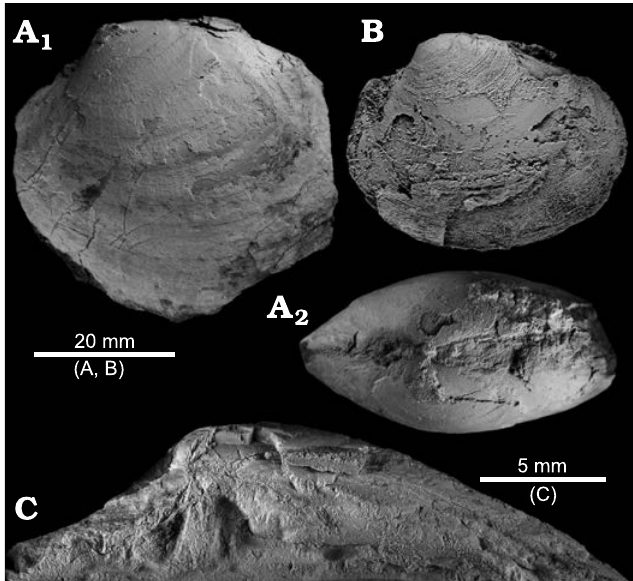
Fig. 14. The vesicomyid bivalve Archivesica ? sp. 2 from Upper Miocene seep deposits of the Amlang Formation in Pangasinan province, Luzon, Philippines. A . NRM Mo 192676, large articulated specimen, view on LV showing interior posterior ridge (A 1 ), dorsal view showing moderate infla- tion and lunule (A 2 ). B . NRM Mo 192678, articulated specimen, view on LV showing general outline. C . NRM Mo 192677, isolated RV, view on hinge.